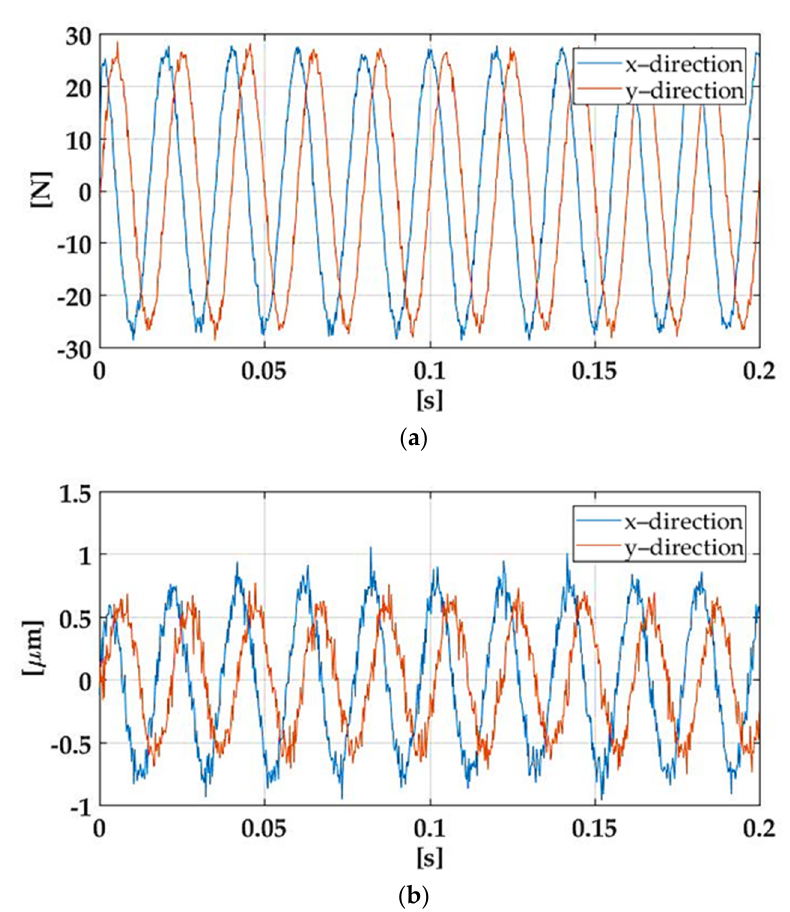
Figure 18. ( a ) Horizontal and vertical forces with SNR of 25 dB; ( b ) measured displacements with SNR of 15 dB, at 3000 rpm.